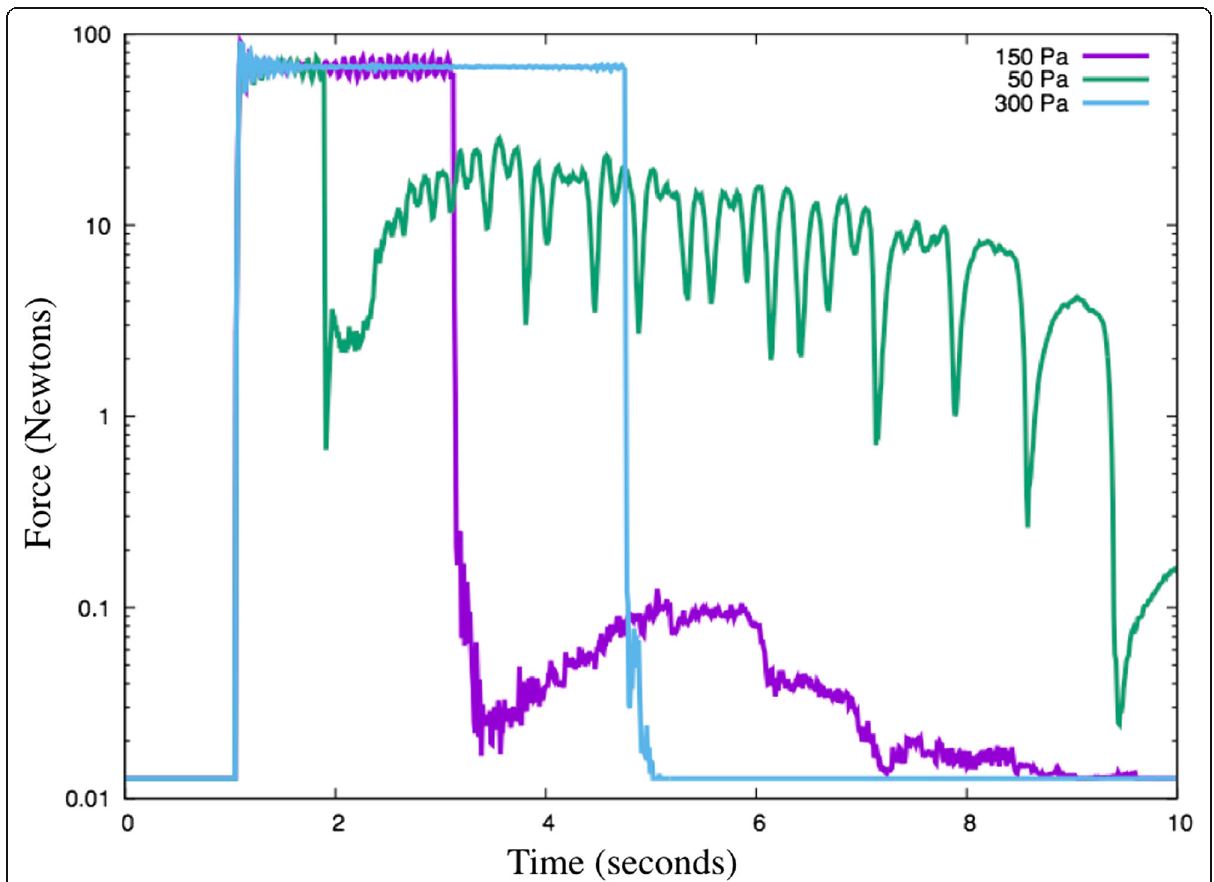
Fig. 2 Force profile acting on system center of mass for Fig. 1. The constant force segment occurs due to the constant force spring in the arm, described in Bierhaus et al.